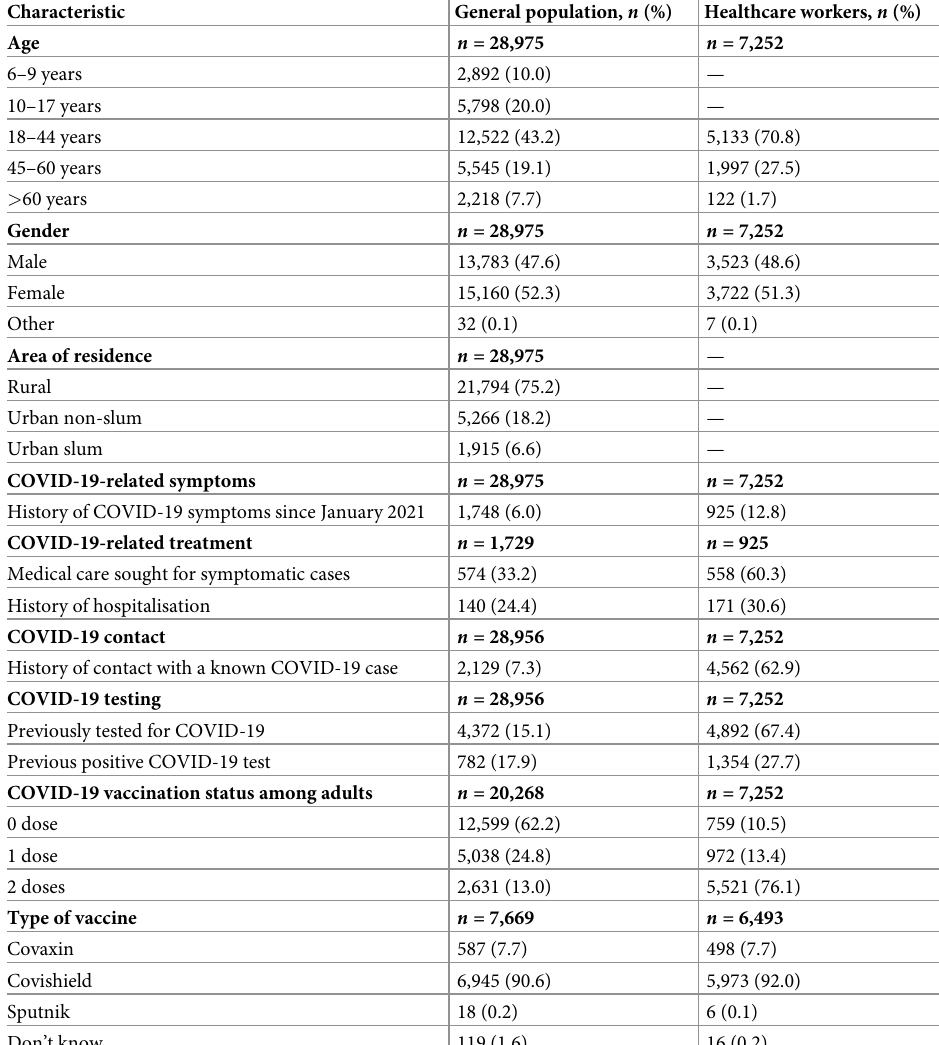
Table 1. Participant